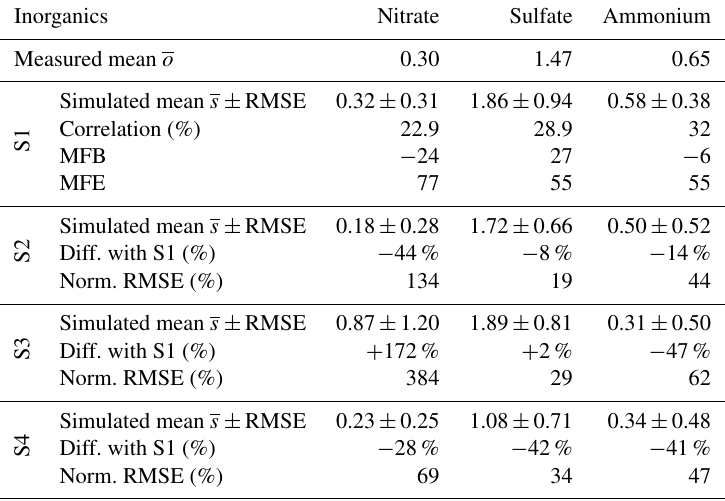
Table 10. Comparisons of simulated PM 1 inorganic daily concentrations to observations (concentrations are in µgm − 3 ) using S1, S2, S3 and S4 during the 2013